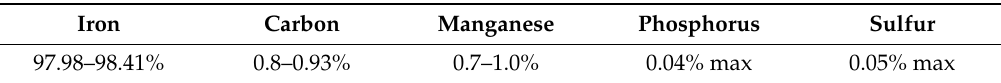
Table 2. Prescribed chemical composition of AISI 1085 steel wire.